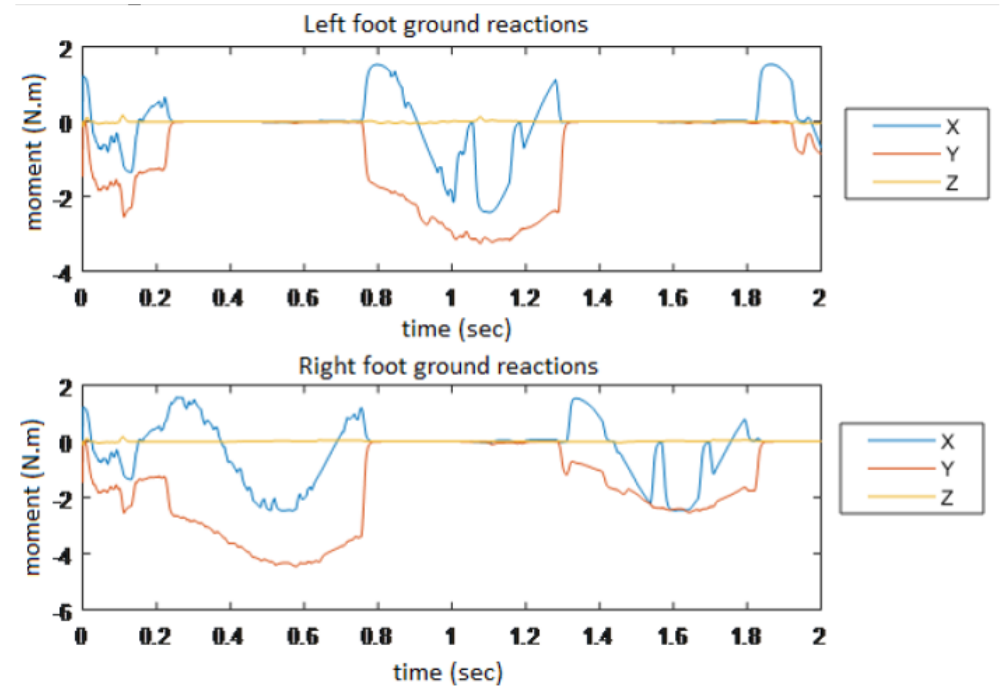
Figure 9. Left and right foot ground reaction moments Mx, My and Mz obtained for the imposed robot gait presented in Figures 4 and